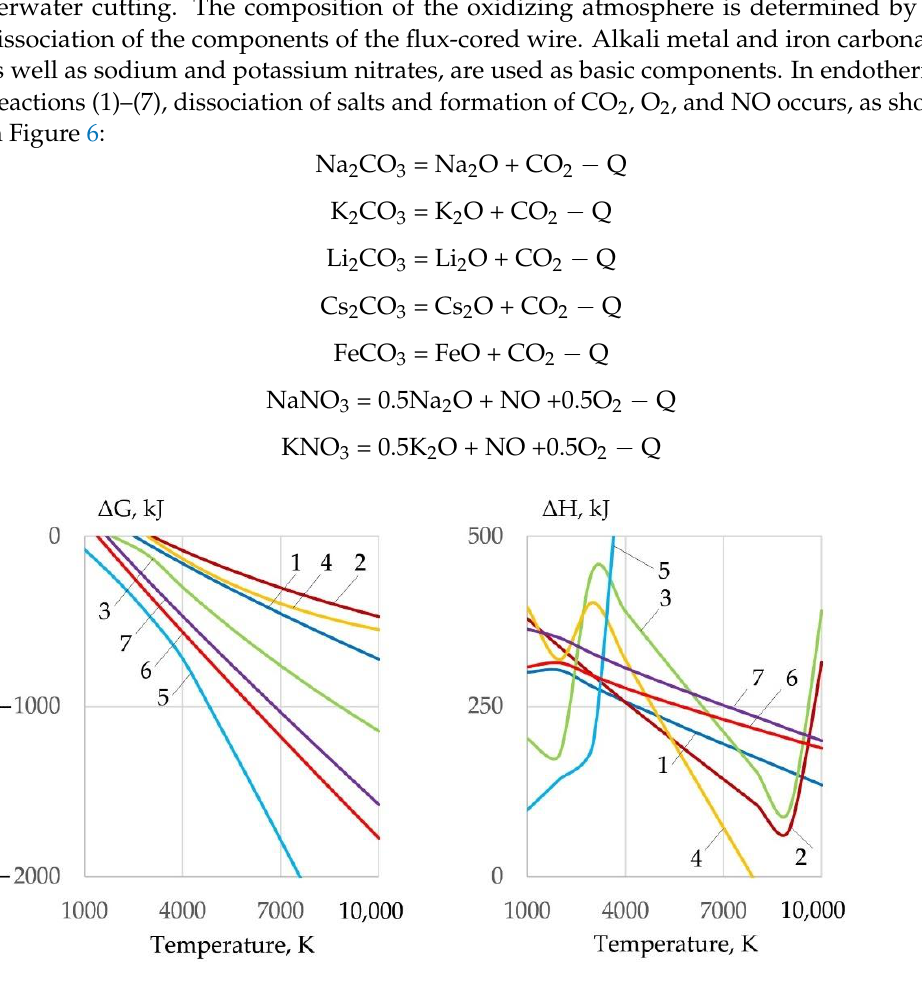
Figure 6. Change of Gibbs free energy and enthalpy of salt dissociation reactions ( 1 – 7 ).